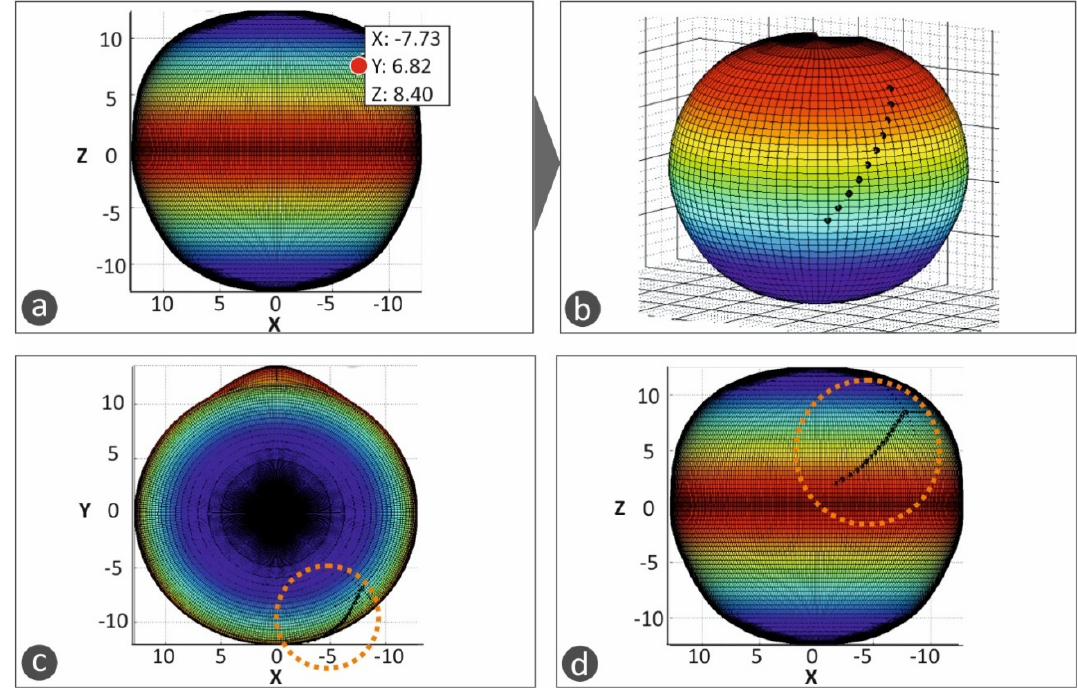
Figure 4. The procedure for the definition of the macular buckle implant trajectory and shape in the software developed in the current work: ( a – d ) show the procedure for the determination of the trajectory the macular buckle geometry should follow. Points are defined by the user in the macula position in the eye and the buckle geometry is defined according to the path defined by these points in space selected in the outer surface of the eye.